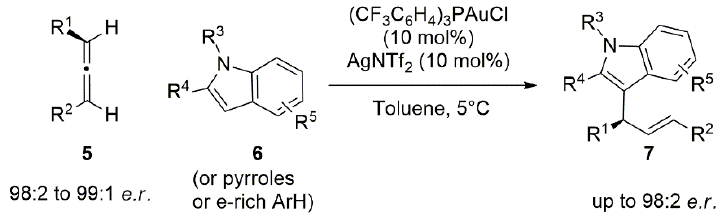
Figure 3. Gold-catalyzed intramolecular hydroarylation of alkynones ( 3 ) for the atroposelective synthesis of axially chiral biaryl derivatives ( 4 ).